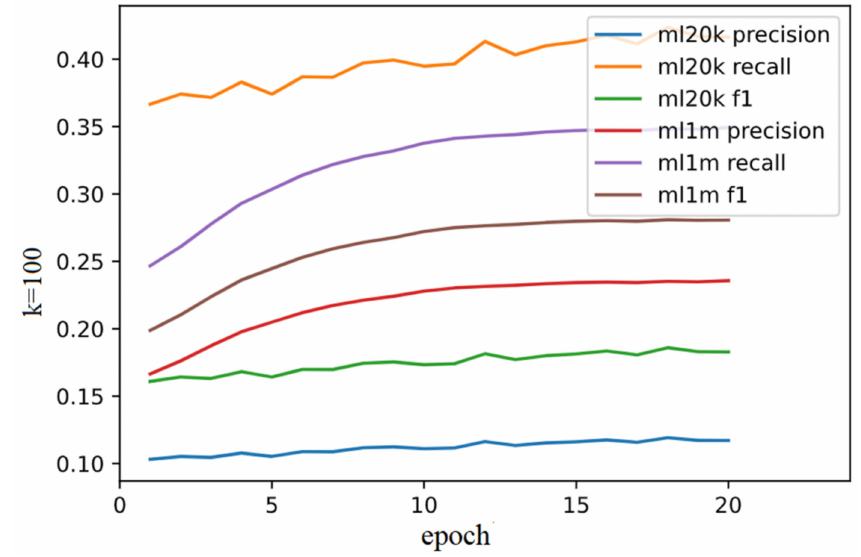
Figure 7. A reflection of the changes in precision, recall, and f1 of the Top 100 on the test